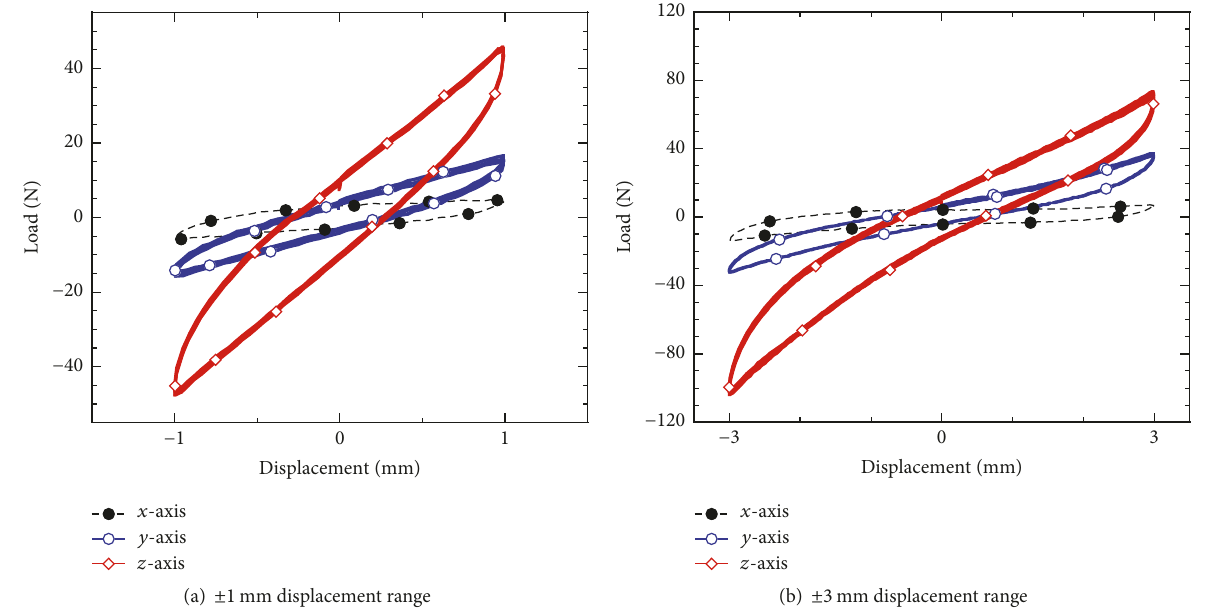
Figure 5: Load-displacement relationships for displacement ranges of 1 mm and 3 mm on each axis ((a): 𝑥 -axis, (b): 𝑦 -axis, (c): 𝑧 -axis).